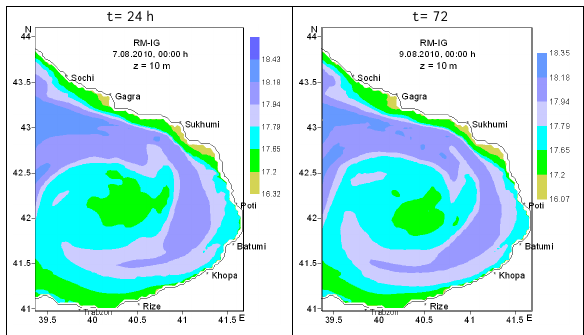
Fig. 10. The salinity fields (psu) on depth of 10 m predicted by BSM of MHI at 24 h (a) and 72 h (b) (the forecasting period is 6.08.2010, 00:00 h –9.08.2010, 00:00 h).